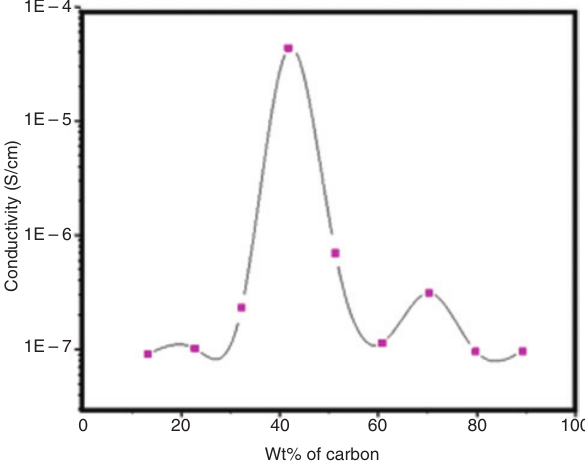
Figure 1: Ionic conductivity of composite.